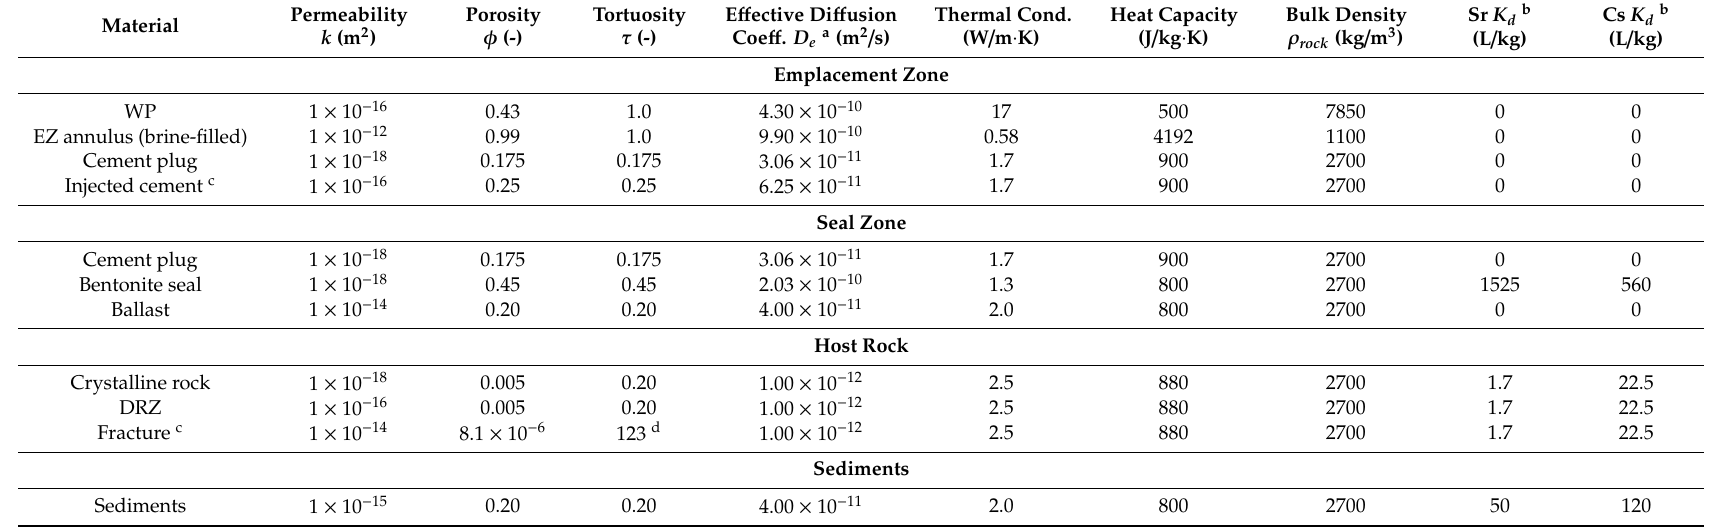
Table 1. Numerical representation of material properties in the performance assessment (PA) simulations. DRZ: disturbed rock zone, EZ: emplacement zone; and WP: waste